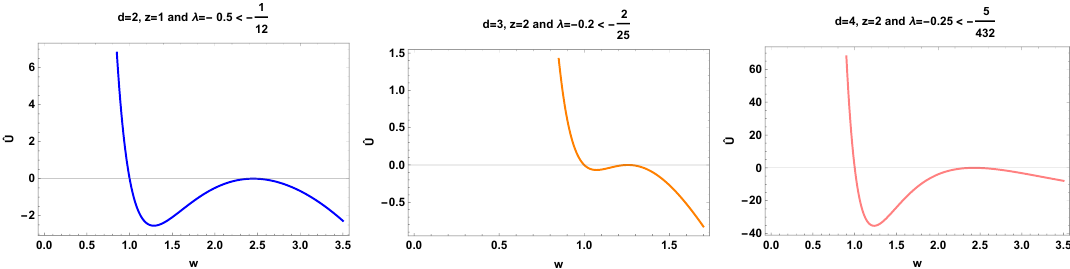
ˆ Figure 5 . The effective potential U ( w ) as a function of w for θ = 0 and different values of d , z and λ . For the values of λ given in table 1, there is a maximum w fA 1 outside the horizon, i.e. w fA 1 > 1 . We set L = r = r = 1 . h F